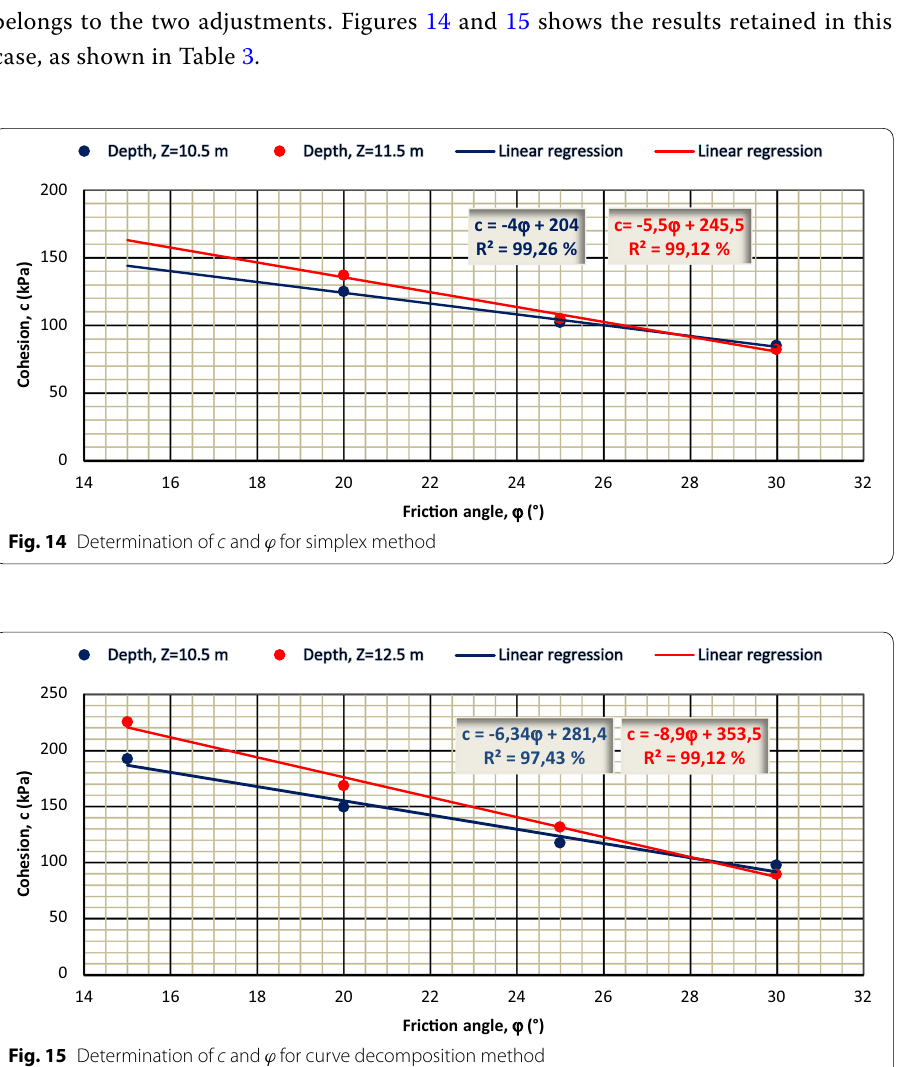
Fig. 15 Determination of c and ϕ for curve decomposition